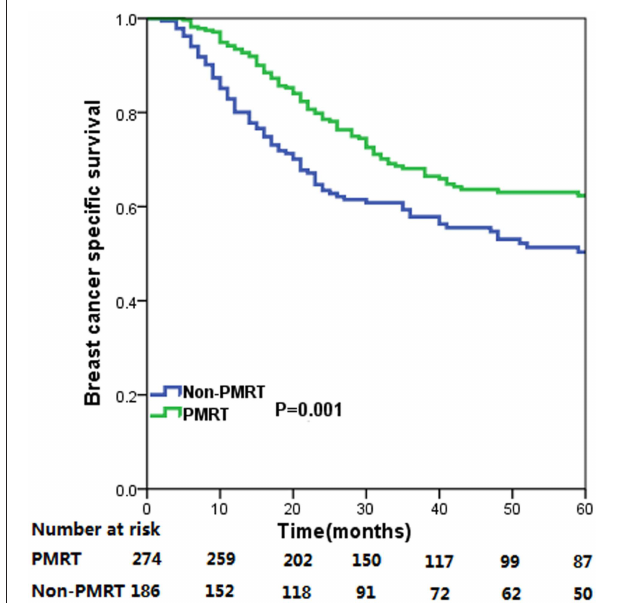
FIGURE 1 | Breast cancer specific survival curves for all cases of metaplastic breast carcinoma with and without post-mastectomy